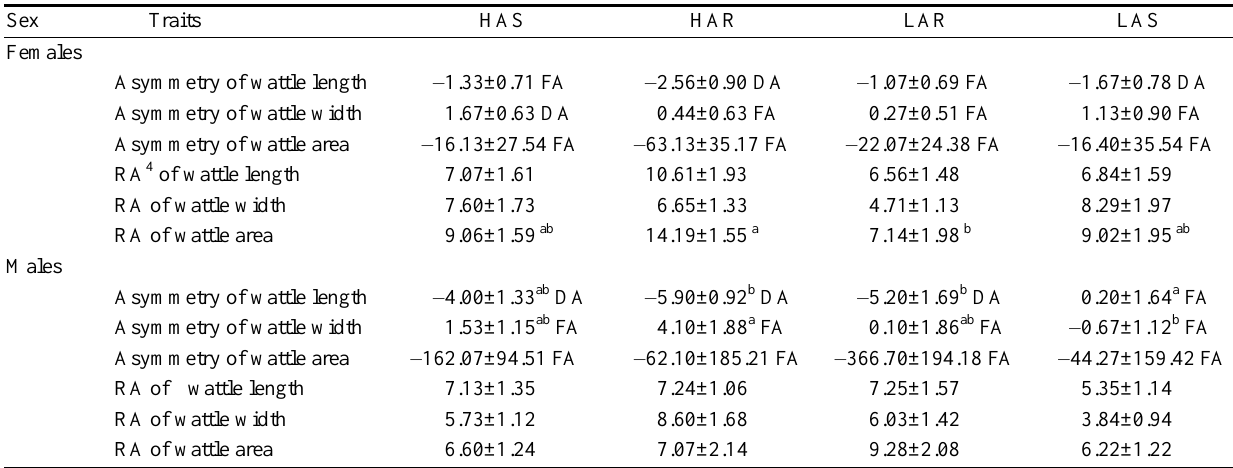
Table 2. Means±SE of asymmetry 1 and RA 2 for males and females by line 3 Sex Traits HAS